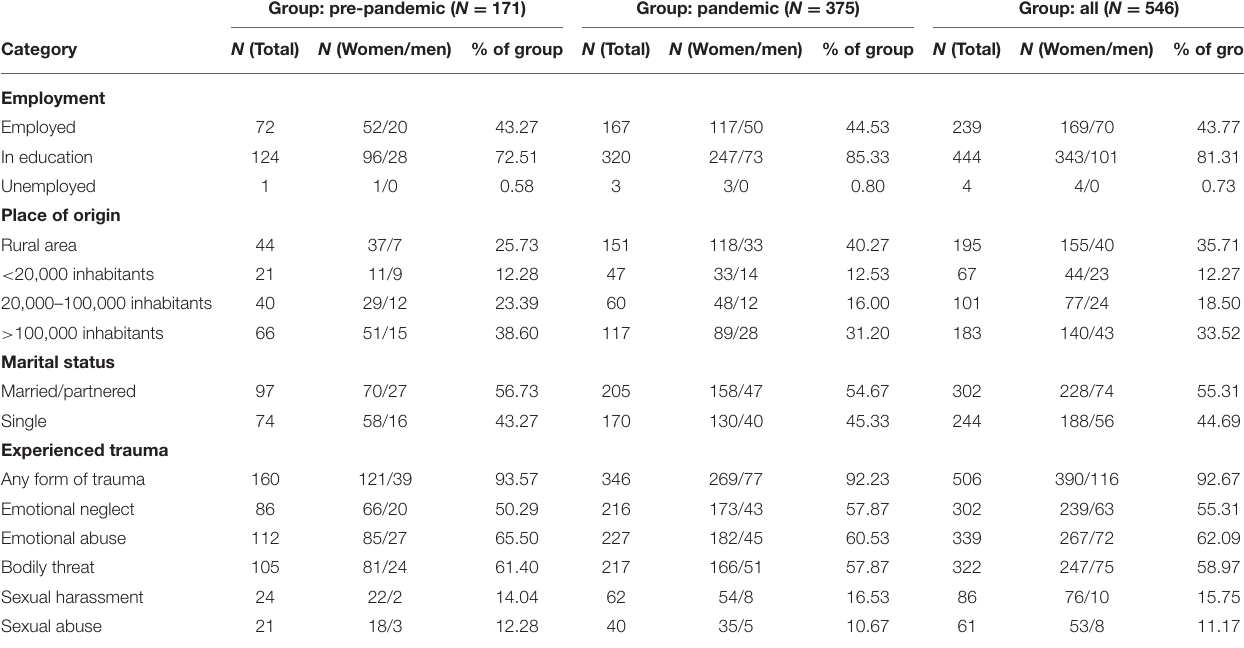
TABLE 1 | Sociodemographic characteristics of the participants by pre-pandemic/pandemic subgroups. Group: pre-pandemic ( N = 171) Group: pandemic ( N = 375) Group: all ( N =